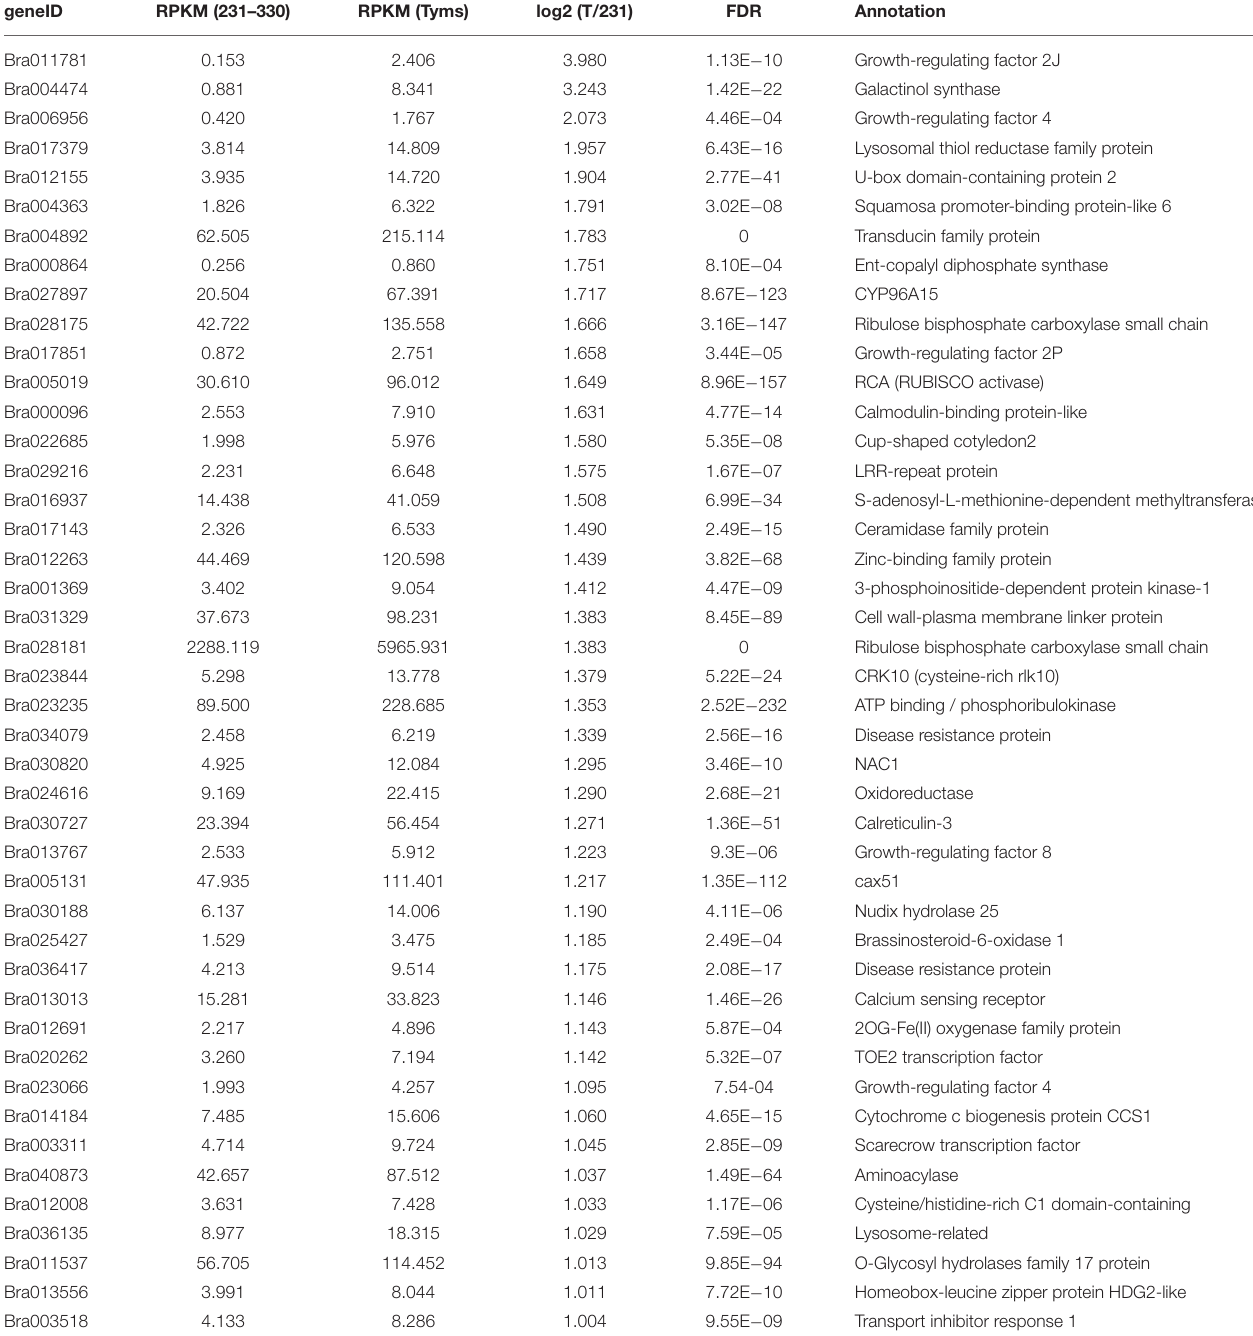
TABLE 4 | The up-regulated targets in Tyms compared to 231-330 buds.